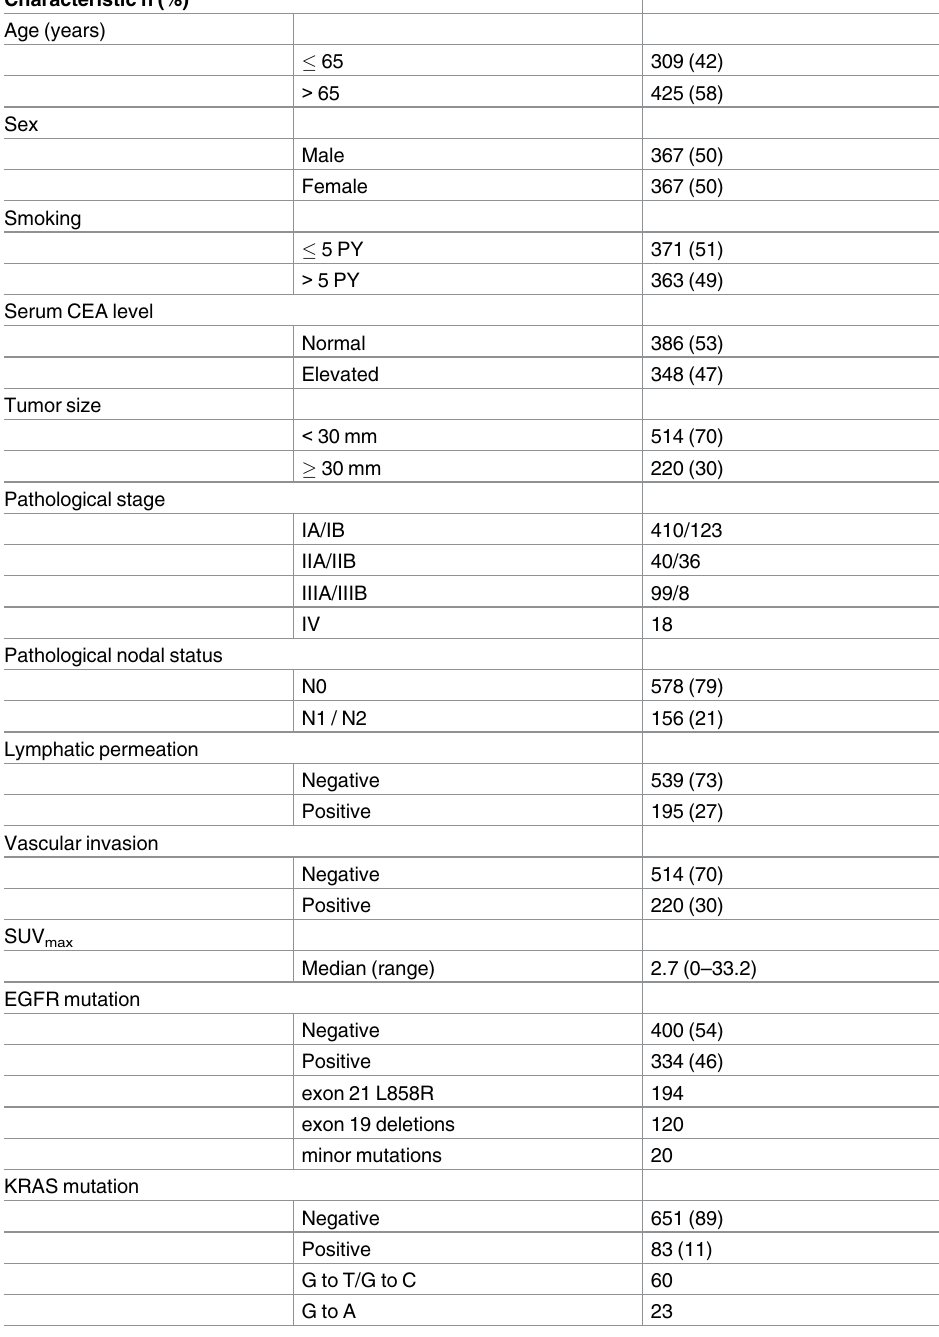
Table 1. Clinical characteristics of